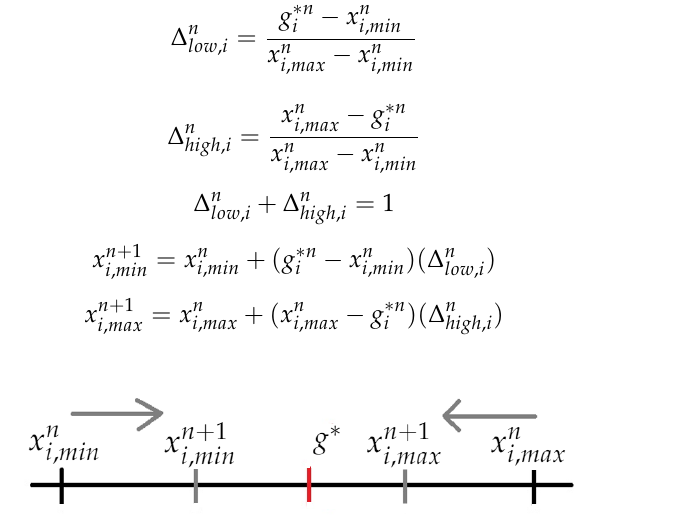
Figure 1. Dynamic search space squeezing under the influence of g ∗ at iteration n + 1. The arrows indicate the squeezing of the search space from iteration n – n +